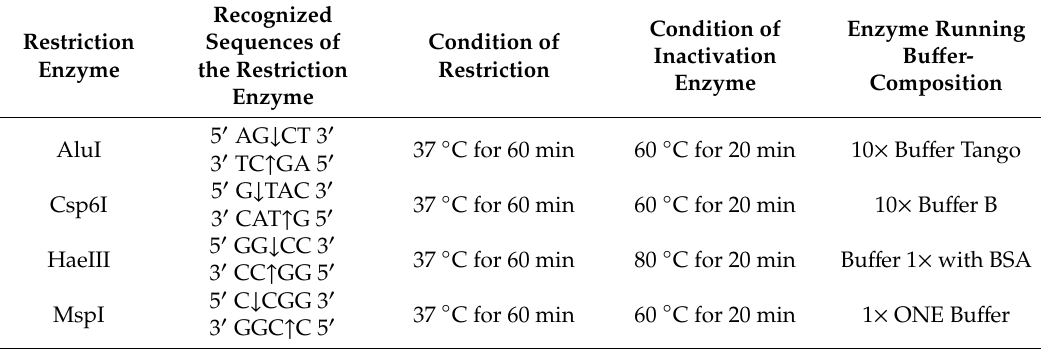
Table 3. Characteristics of the restriction enzymes used in the t-RFLP